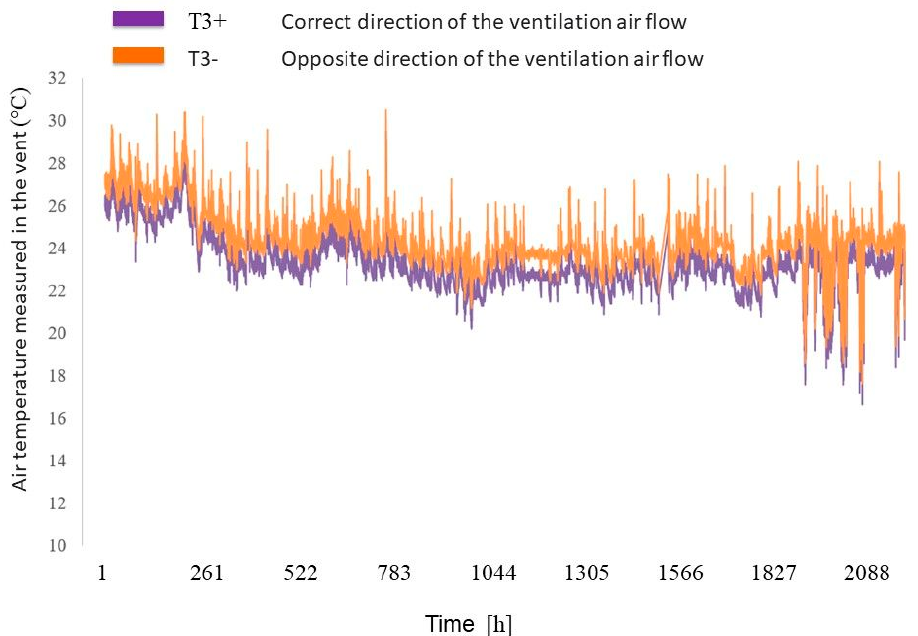
Figure 12. Air temperature measured in the vent.